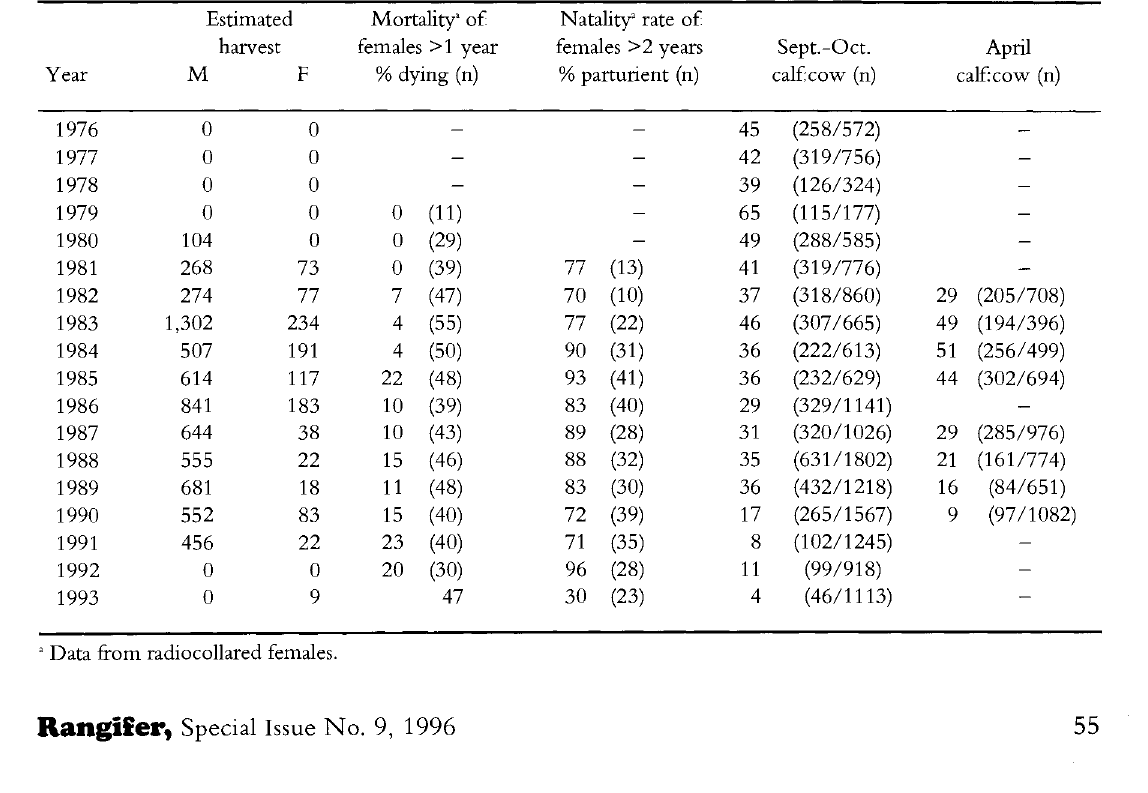
Table 2. Harvest, adult natural mortality, natality and recruitment in the Delta caribou herd, 1976-1993.